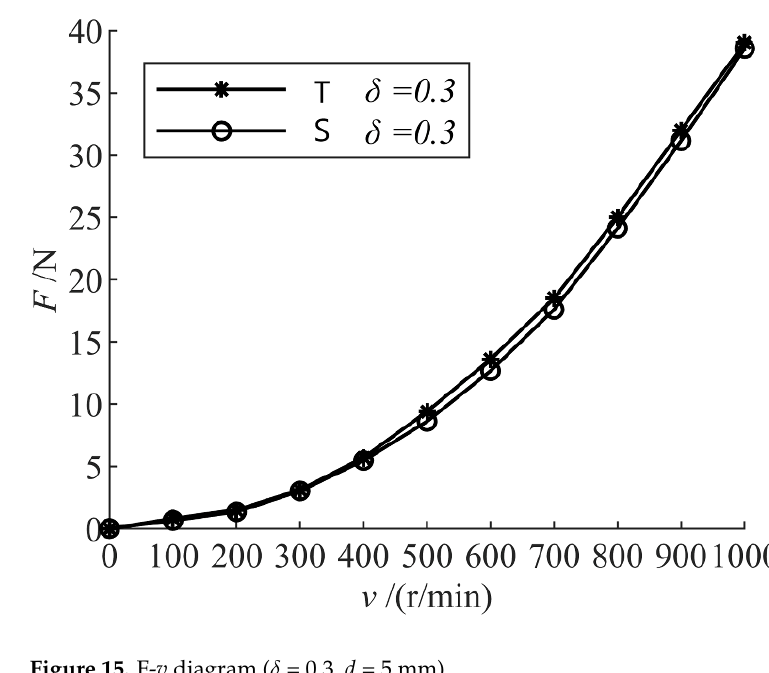
Figure 15. F- v diagram ( δ = 0.3, d = 5 mm).